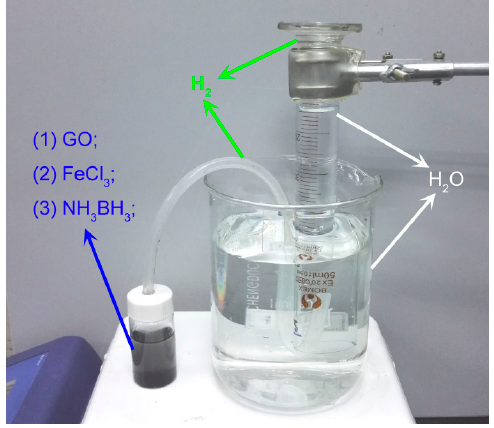
Figure 7. The instrument to measure the H 2 contends.